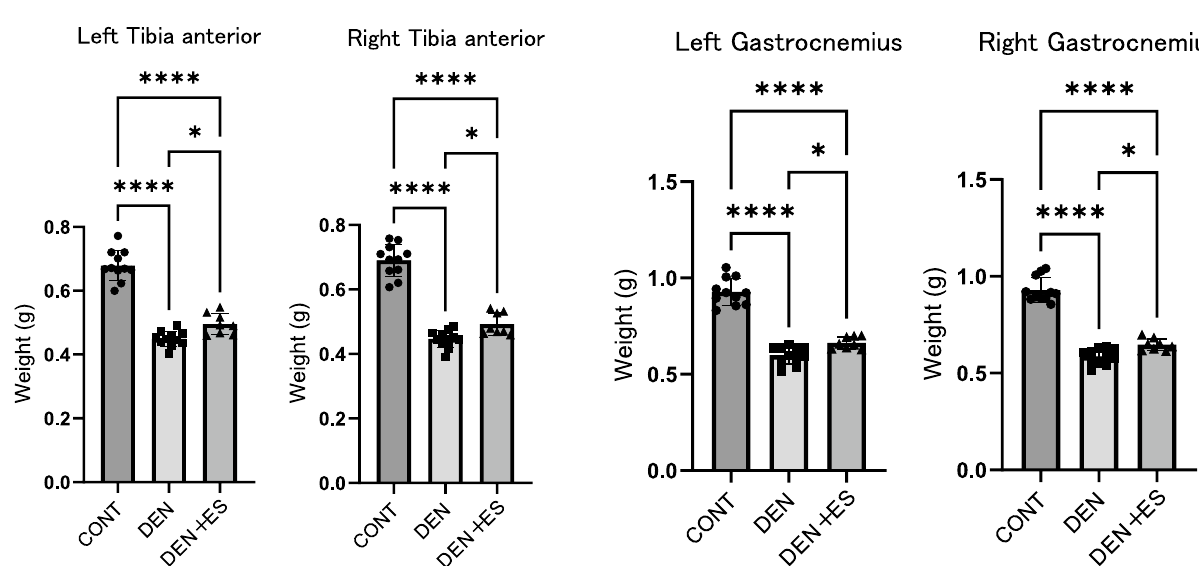
Figure 2. Muscle wet weight of left and right GAS and TA after chronic belt electrode stimulation. Mean ± SD. One-way ANOVA test was used to evaluate changes in the wet weight of the lower limb muscles 24 h after chronic stimulation with a belt electrode. CONT unstimulated control group, DEN denervation muscle atrophy induced group, DEN + ES denervation muscle atrophy induced + by belt electrode electrical stimulation group;